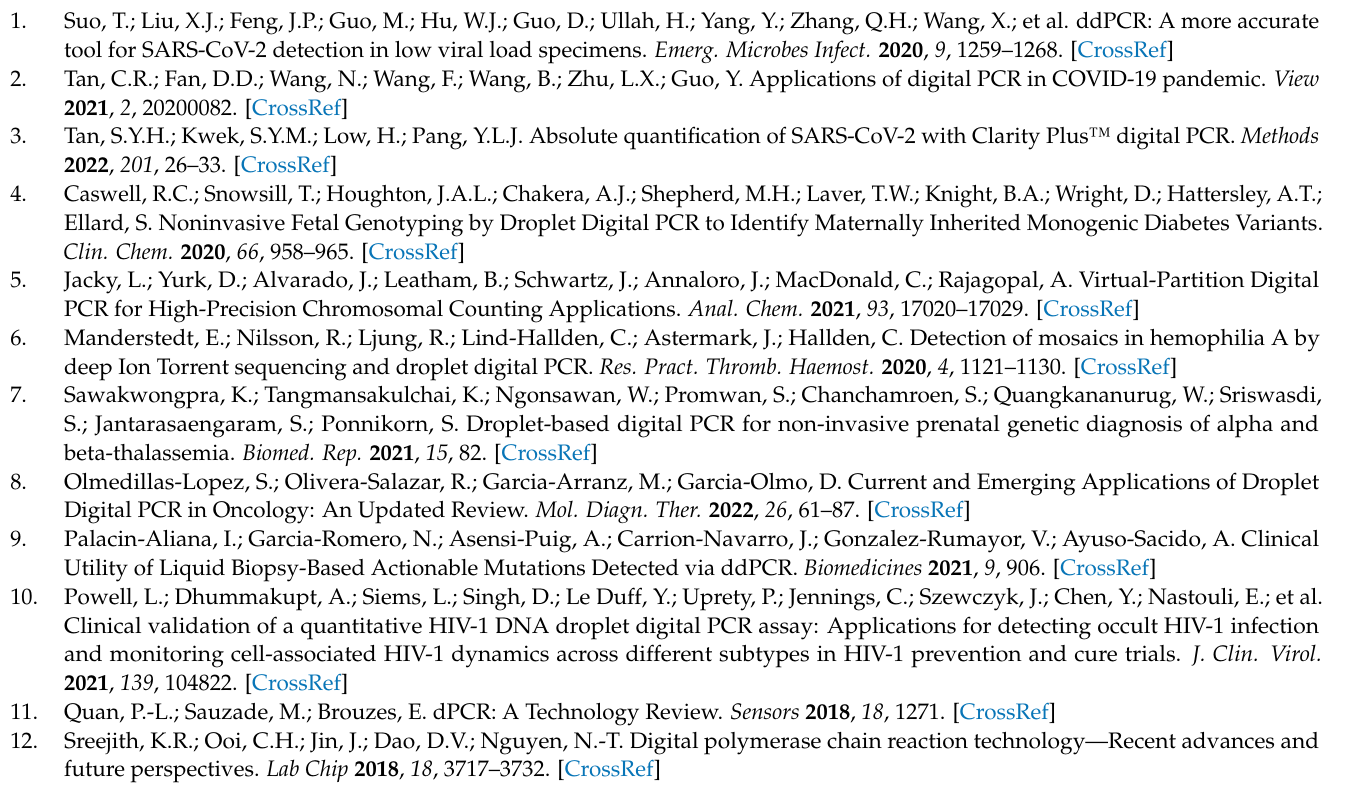
of the image before and after vignette correction was counted; Figure S5: The resulting graph was obtained by segmenting the droplets in the image after vignetting correction of the fluorescence image; Figure S6: Droplets with wrong segmentation, droplets not validly identified, and droplets with incomplete edges in the image; Figure S7: Flow chart of three types of bright field image droplet segmentation workflows; Figure S8: The results of bright-field image droplet segmentation for the three algorithms. Table S1: The difference between the eight corner areas and the central area and the average of the difference between the eight corner areas and the central area in Figure S4a; Table S2: The difference between the eight corner areas and the central area and the average of the difference between the eight corner areas and the central area in Figure S4b; Figure S9: Accuracy values given by different image analysis methods; Figure S10: Fill different channels with droplets; Figure S11: Droplets in multiple layers versus droplets in one layer; Figure S12: How merged droplets are treated in the image analysis. The droplet classification information by applying image processing algorithm statistics can be downloaded at: Additional File